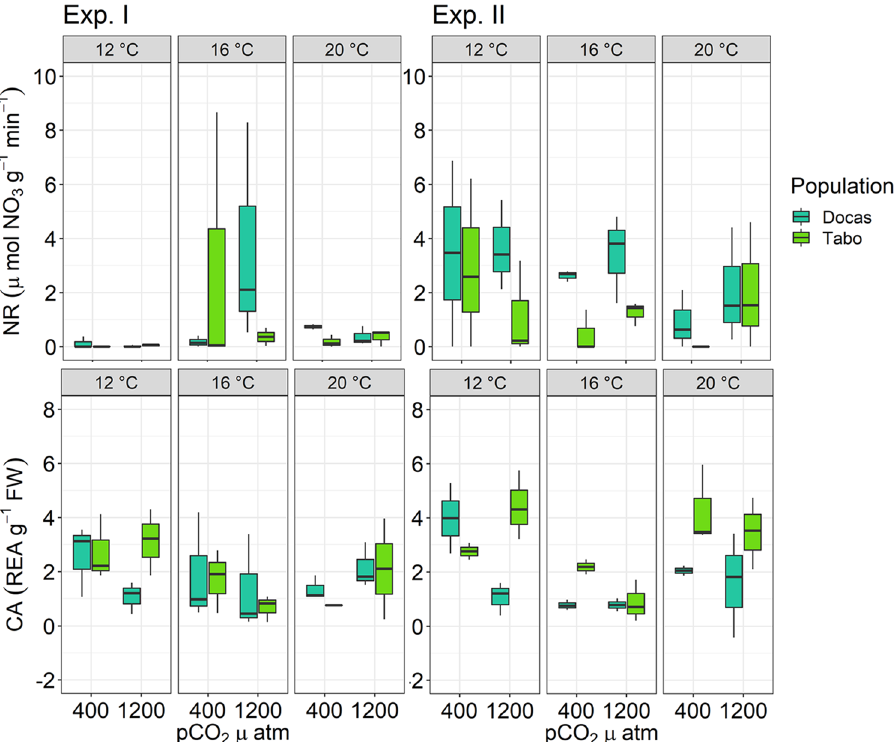
Figure 2. Nitrate reductase (NR) and Carbonic anhydrase (CA) activities of juvenile Macrocystis sporophytes from Las Docas and El Tabo incubated for three weeks (Experimental trial I and II) under three temperature (12, 16 and 20 °C) and two pCO 2 treatments (~ 400 and 1200 µatm). Box-plots showing median size (line within box), 25th and 75th percentiles (ends of box), and minimum and maximum distribution of the data